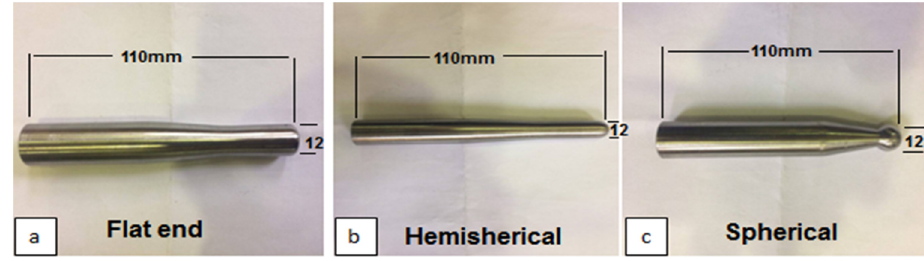
Fig. 8. Forming tool